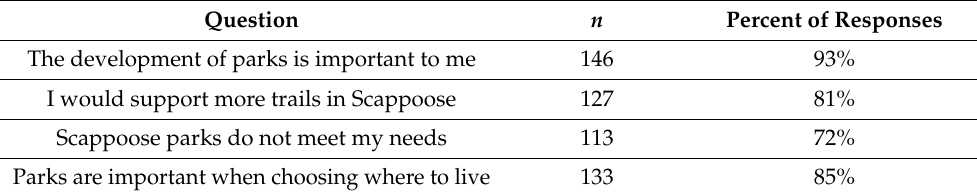
Table 6. Community Green Space Survey ( n =